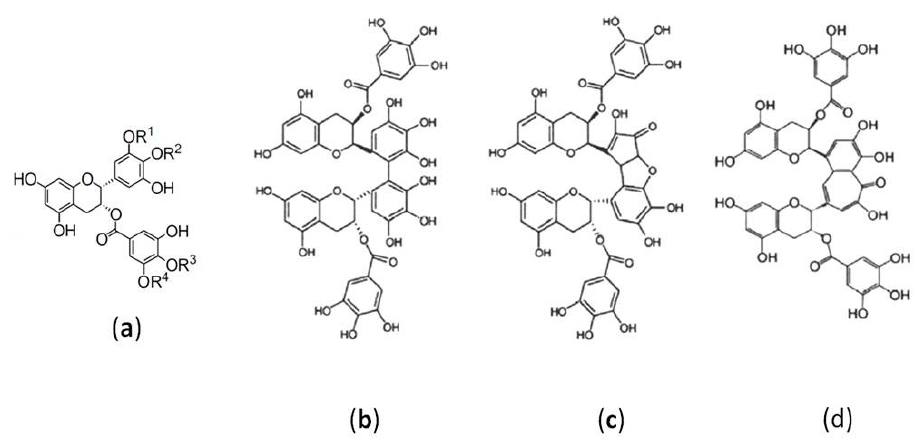
Figure 3. The structurally modified EGCG or dimers with with stronger effects against virus. ( a ) EGCG-monopalmitate derivatives composed of four regioisomers in different proportions of 1, 2, 3 and 4 against IAV and HSV-1. The EGCG dimers theasinensin A ( b ), P2 ( c ), and theaflavin-3, 3-digallate ( d ) inactivating HSV-1 and HSV-2 more effectively than